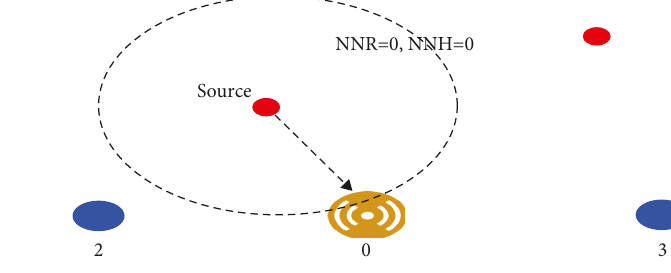
Figure 16: Nanointerface within the transmission